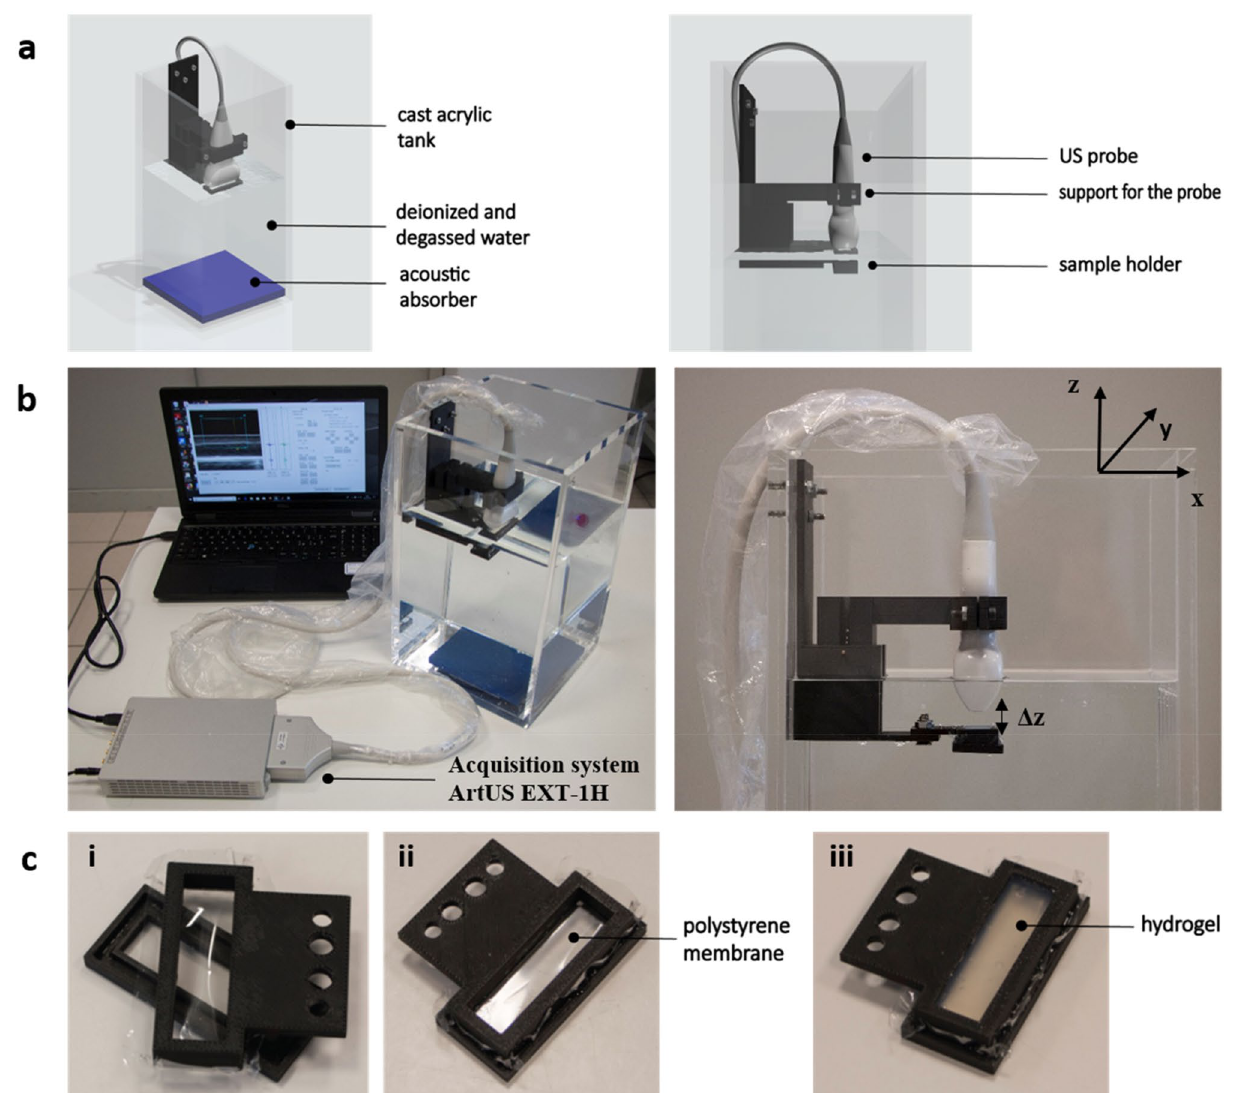
Figure 2. Experimental setup for US acquisition. ( a ) Schematic representation of the setup; ( b ) images of the real experimental setup, including the acquisition system and the pc; ( c ) structure of the sample holder: in i)